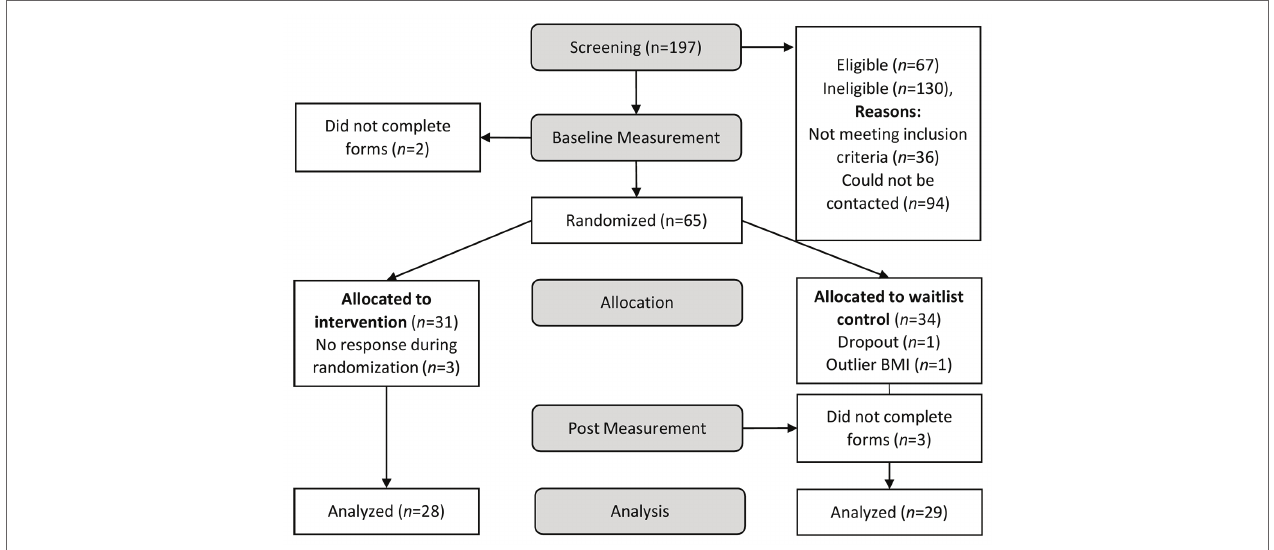
FIGURE 1 | Phases of the study design and number of participants who completed each phase. Participants that met eligibility criteria were invited to fill out the baseline